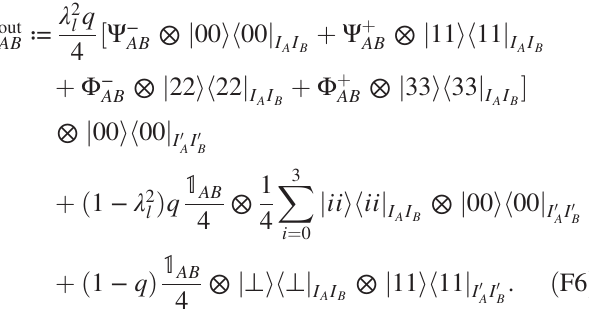
ffiffiffi p 3 Þ(cid:2) , for which the depolarizing channel is nonzero, and hence, its private capacity is nonzero as